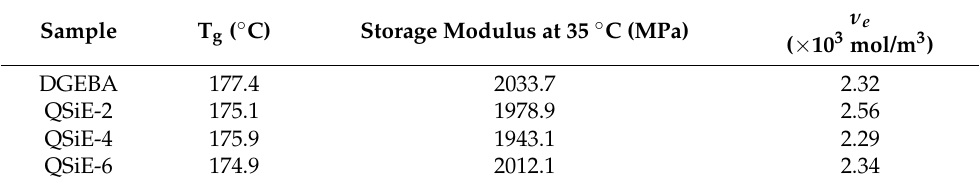
Figure 3. Storage modulus ( a ), Tan δ ( b ), tensile strength and elongation at break ( c ), and impact strength ( d ) of cured thermosets. strength ( d ) of cured thermosets. Table 2. Thermal-mechanical properties of cured